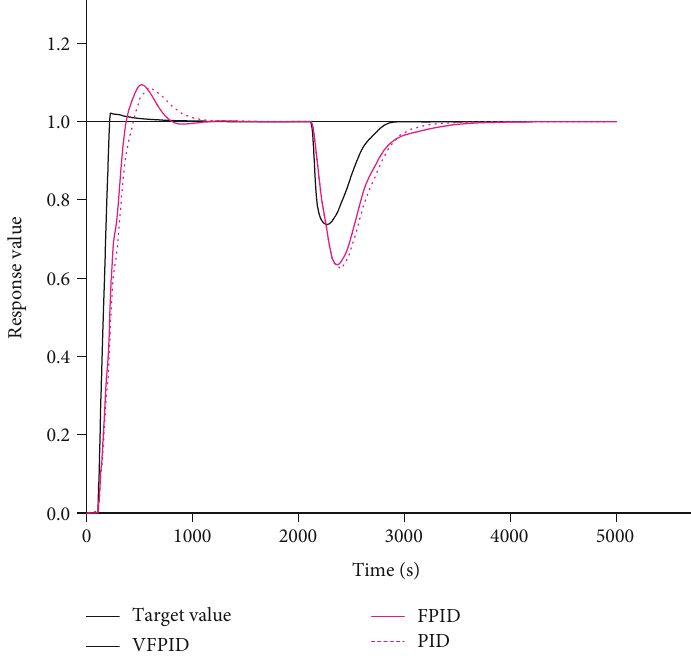
Figure 9: Disturbance regulation